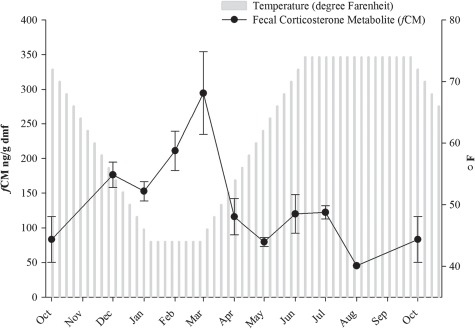
Weekly water temperature (°F) and mean ± SEM monthly fecal corticosterone (fCM) concentrations in 2016–2017 for six natural breeding pairs of Necturus beyeri at Jacksonville Zoo and Gardens. Fecal collection began in December 2016 and concluded in October 2017; data are presented with October 2017 adjacent to November 2016 for visual comparison